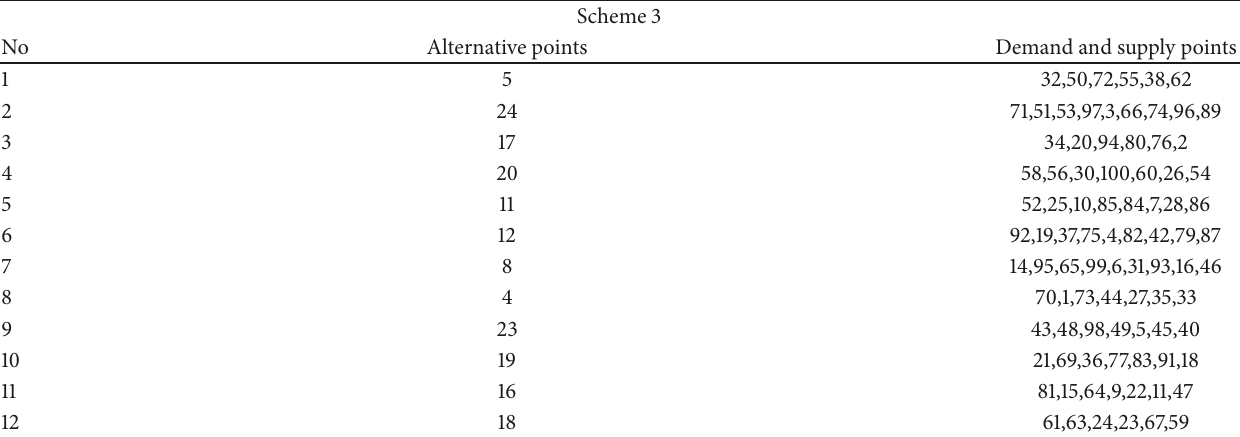
Table 11: The relationship between location and demand distribution of scheme 3. Scheme